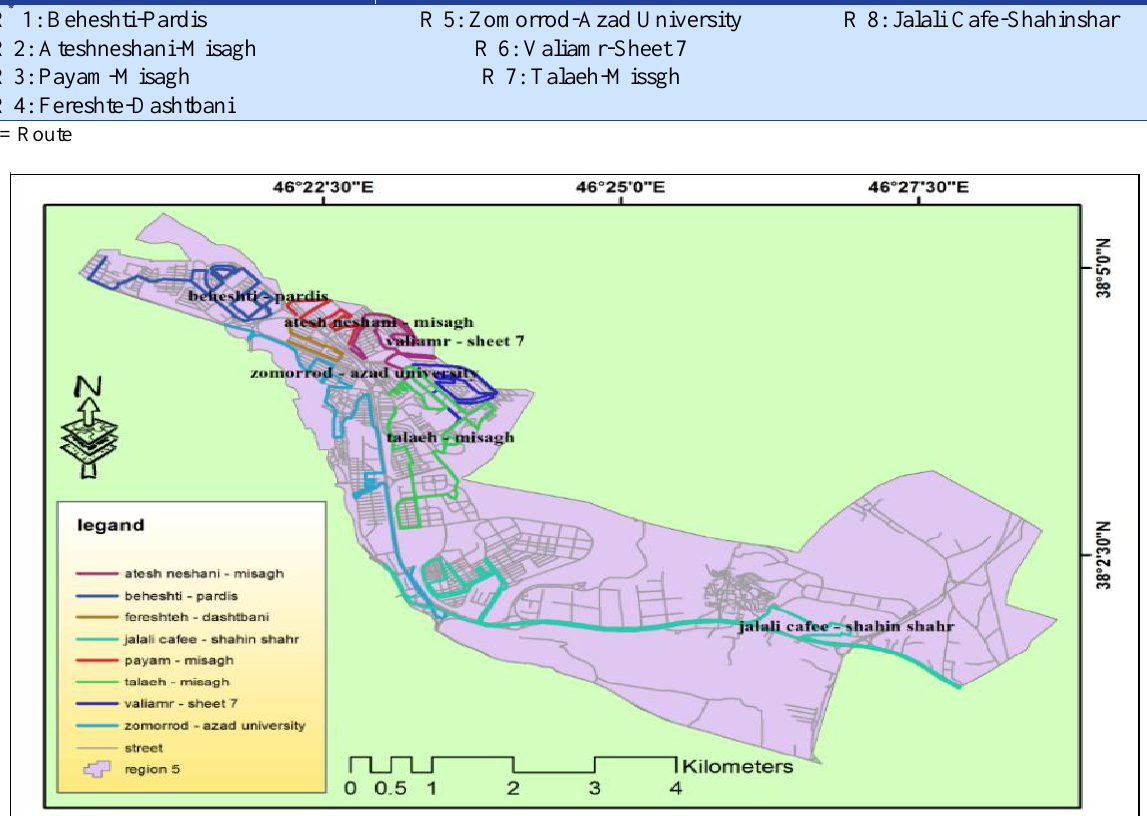
Table 1. Solid waste collection routes in the three areas of the 5 th district of Tabriz Routes of area 1 Routes of area 2 Routes of area 3